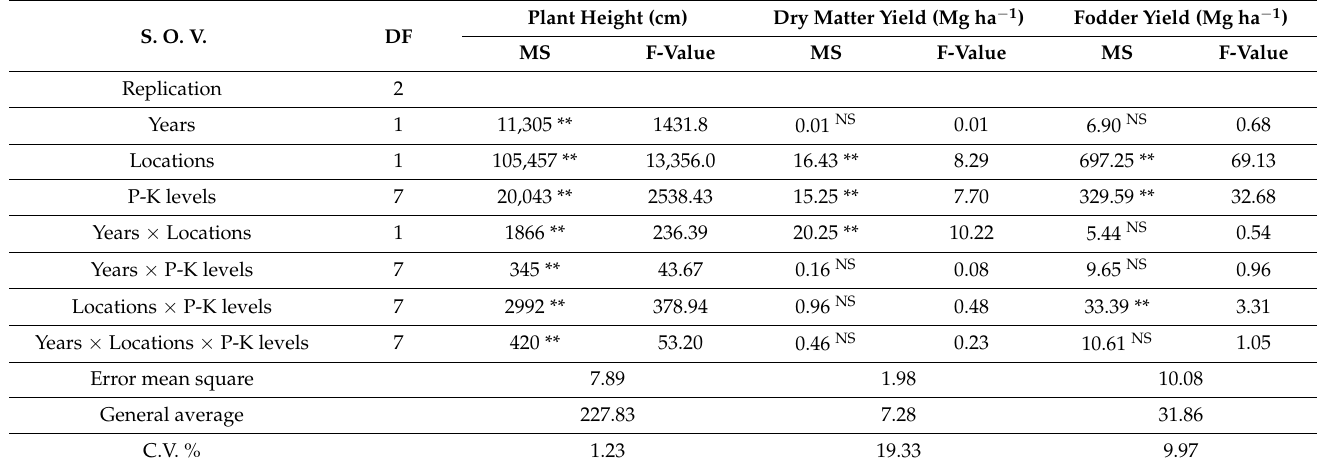
Table 2. ANOVA table of growth and yield traits of sorghum during both years and locations.